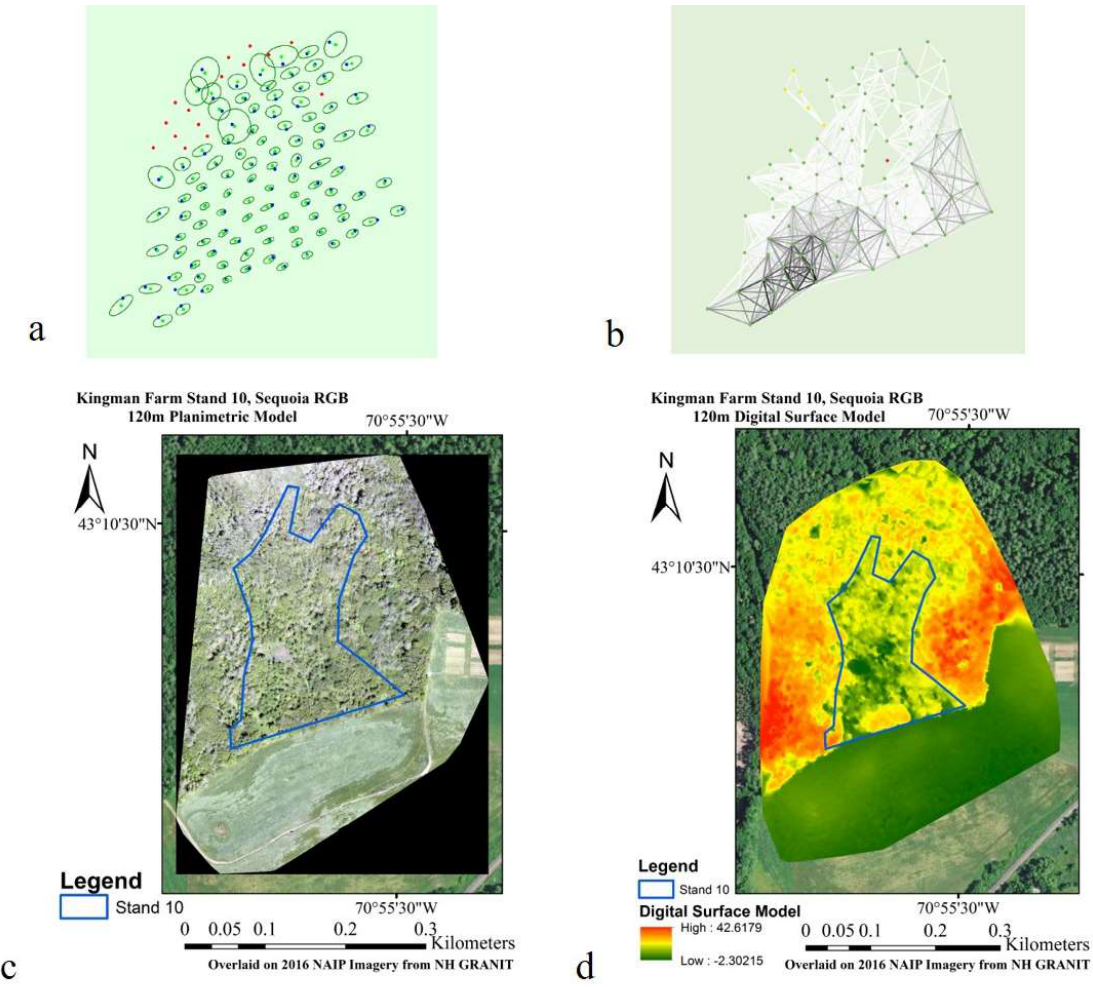
Figure 8. Pix4D mapper Pro initial processing results for the Sequoia RGB sensor at a 120-m flying height above the canopy height model: ( a ) image alignment success (green), failure (red), and additional uncertainty in location (green lines to blue location); ( b ) image-matching strength (weight of line network), and image geolocation error (circle area); ( c ) final orthomosaic product; and ( d ) DSM.